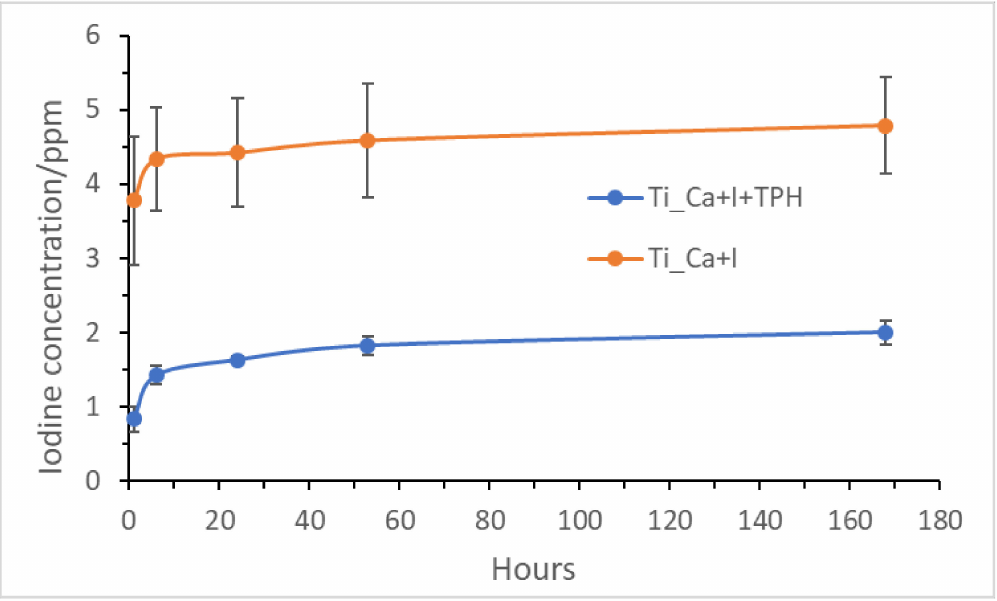
Figure 4. Iodine concentration released from Ti_Ca+I and Ti_Ca+I+TPH as a function of the soaking time in PBS (in hours).